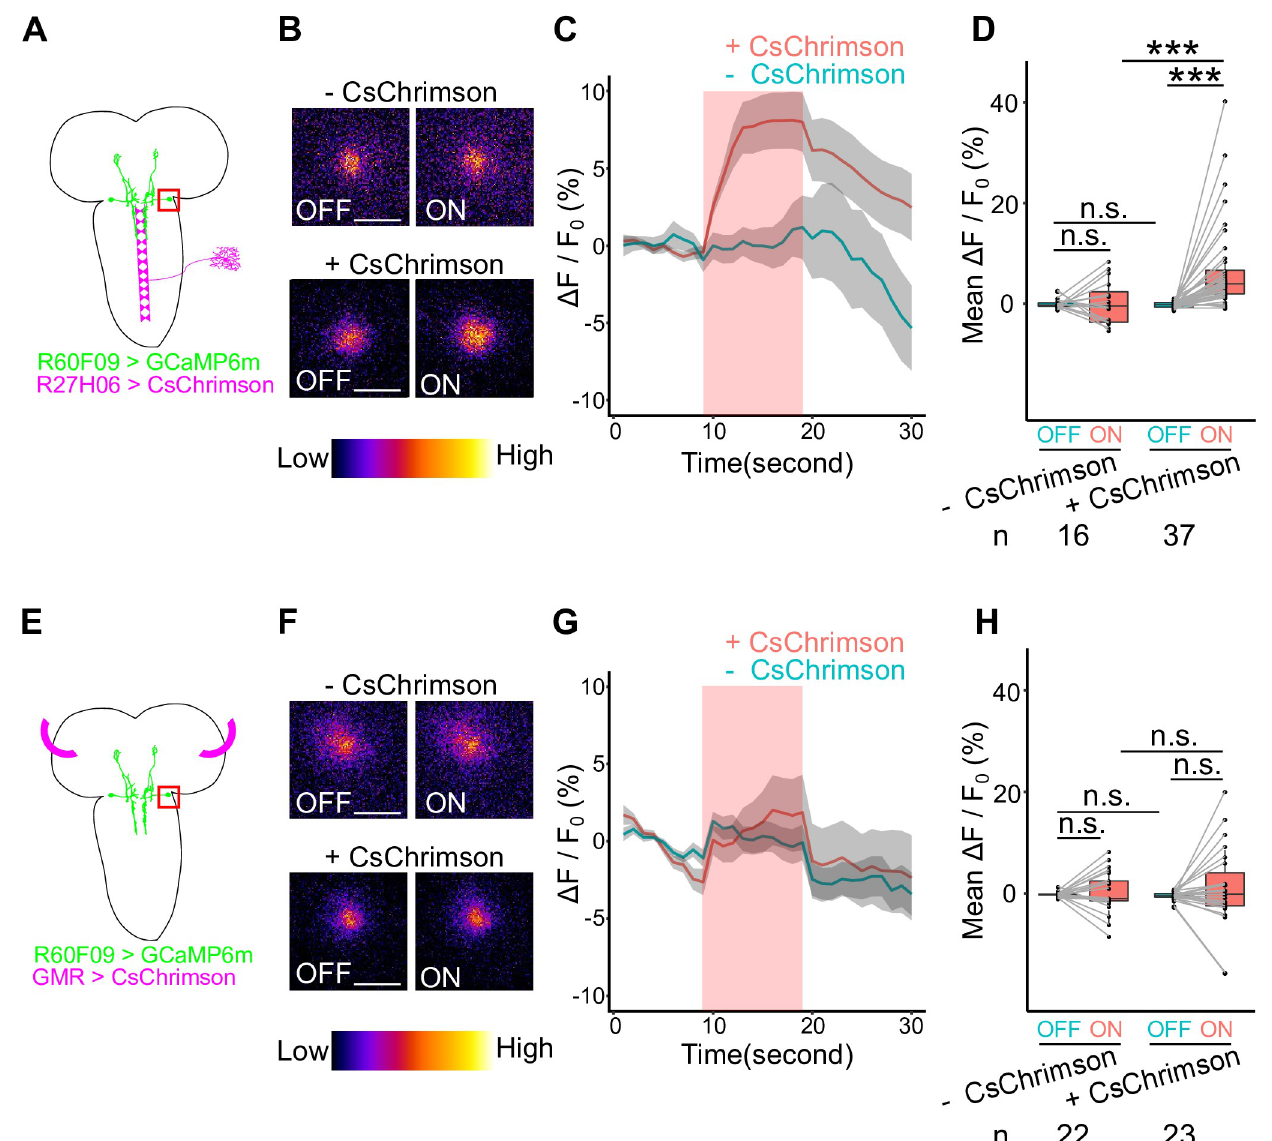
Fig 11. Optogenetic activation of C4da neurons causes Ca 2+ responses in AMBs. (A, E) Schematic views of Ca 2+ imaging on AMB’s soma during optogenetic activation of sensory neurons. Genotypes: w ; UAS-GCaMP6m , tsh-GAL80 / R27H06-LexA ; R60F09-GAL4 / LexAop-CsChrimson (+ CsChrimson ); w ; UAS-GCaMP6m , tsh-GAL80 /+; R60F09-GAL4 / LexAop-CsChrimson (- CsChrimson ) (A-D); w ; GMR-GAL4 / R60F09-LexA ; UAS-CsChrimson / LexAop- GCaMP6m ( +CsChrimson ); w ; R60F09-LexA /+; UAS-CsChrimson / LexAop-GCaMP6m ( -CsChrimson ) (E-H). (B, F) Ca 2+ imaging of AMB neurons upon optogenetic activation of sensory neurons in +CsChrimson (lower panels) and -CsChrimson (upper panels) conditions. Here are shown representative images of relative Ca 2+ levels 5 seconds before (OFF) and after (ON) light application. Scale bars, 10 μ m. (C, G) Time series of Ca 2+ responses in the soma of AMBs upon optogenetic activation of sensory neurons. We applied stimulation in the period indicated by the red band. Data are shown as the mean ± SEM. (C) -CsChrimson, n = 16; +CsChrimson, n = 37. (G) -CsChrimson, n = 22; +CsChrimson, n = 23. (D, H) Average of AMB Δ F/F 0 values in 10 seconds before (OFF) or during (ON) optogenetic activation. In the boxplot, the width of the box represents the interquartile range. The whiskers extend to the data point which is less than 1.5 times the length of the box away from the box, and the dot represent outlier. We assessed statistical significance by paired t -test for paired samples and Welch’s two sample t -test for unpaired samples. ��� p < 0.001. blue light irradiation whereas no significant increase of the fluorescence intensity was observed in larvae ablated C4da neurons (S5 Fig; + rpr , 0.74% ± 2.23% elevation of Δ F/F0 on average, n = 43; - rpr , 7.40% ± 3.17% elevation of Δ F/F0 on average, n = 40). This data indicates that